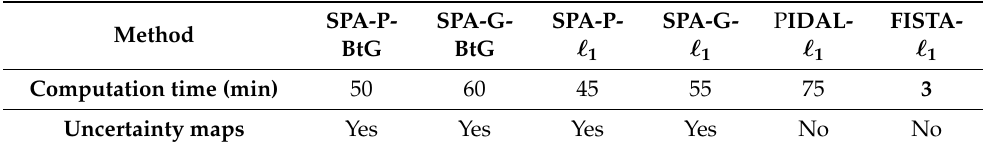
Table 2. Computation time (in minutes), using CPU for the proposed approach and state of the art algorithms.